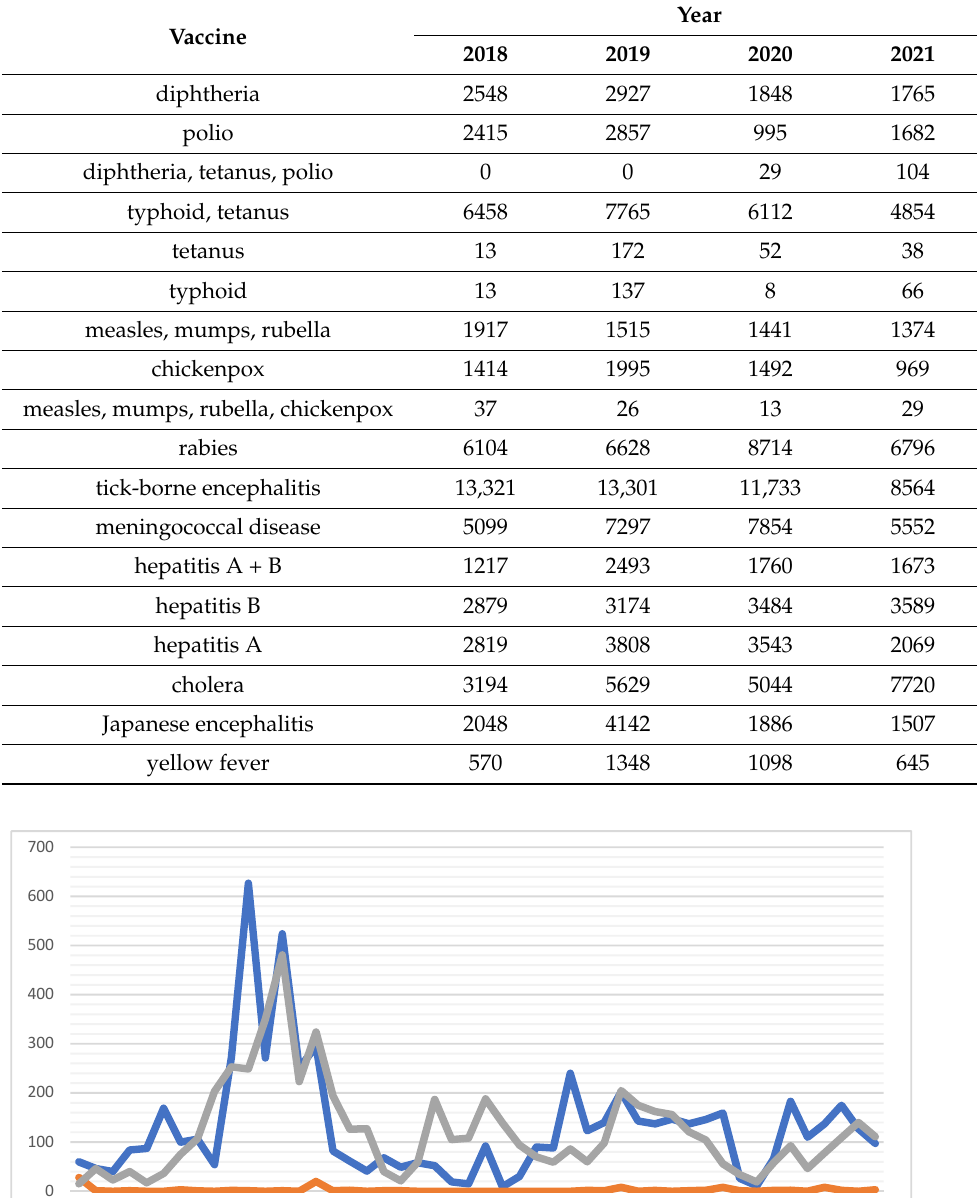
Table 1. Number of vaccinations performed among soldiers in 2018–2021.